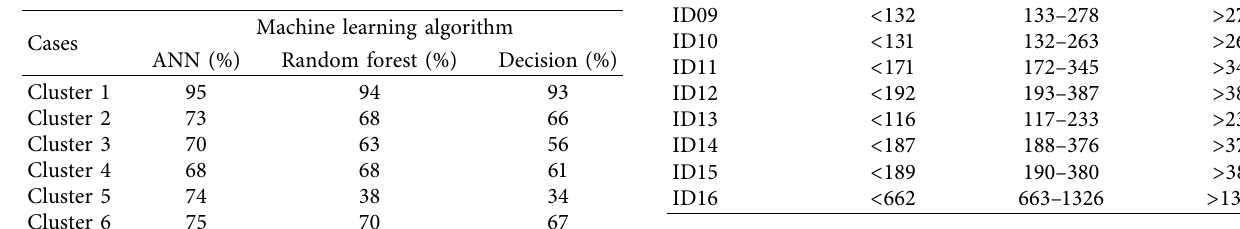
Table 17: Precision accuracy of each algorithm.